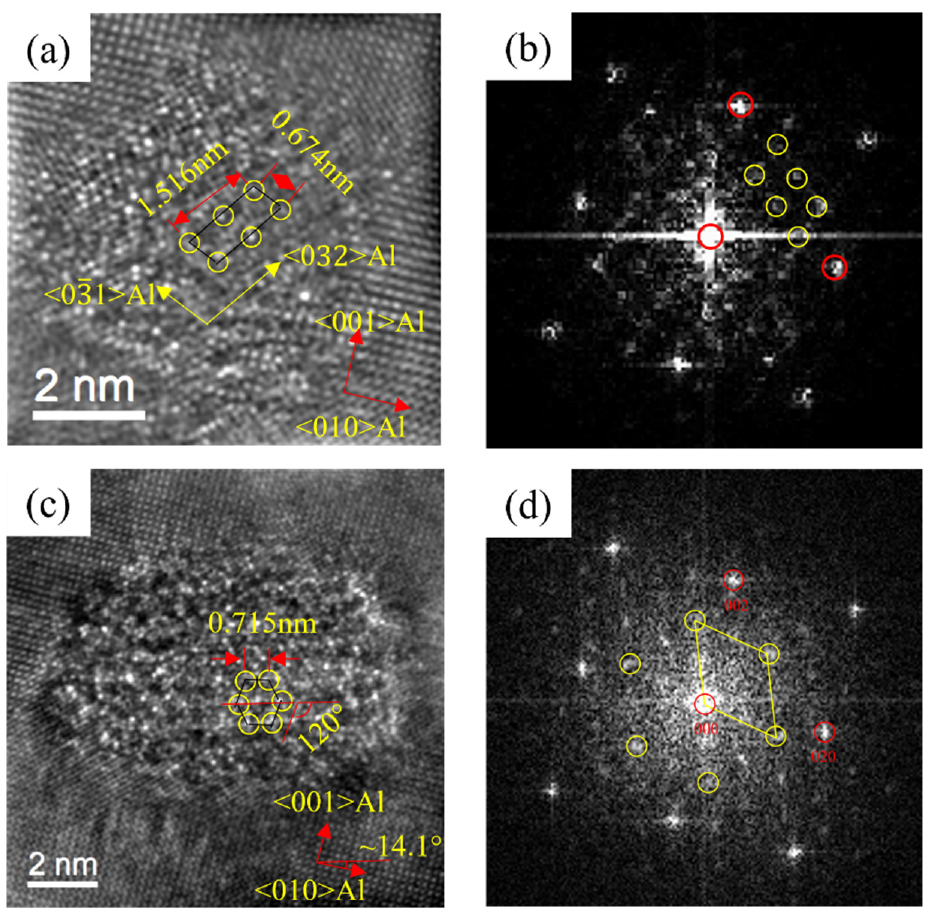
Figure 13. HRTEM and FFT patterns of 0Cu alloy precipitated after over-aging at 175 ◦ C for 72 h. ( a , b ) β″ ; ( c , d ) β ’.